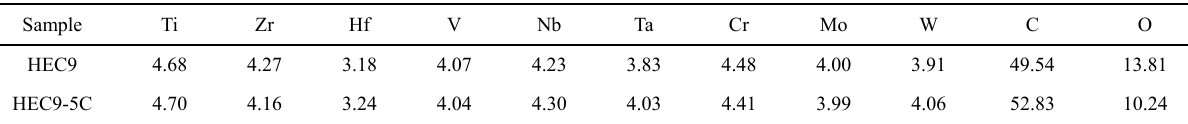
Table 1 Atomic percentages of the elements in the sintered HEC9 and HEC9-5C ceramics by the EDS analysis (Unit: at%)